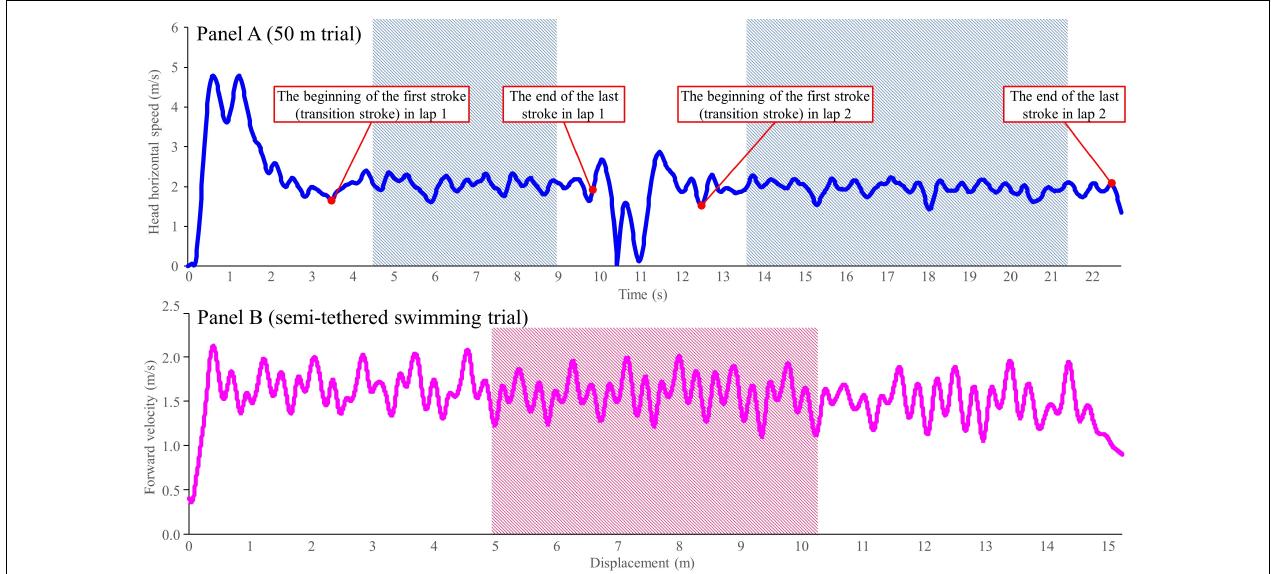
FIGURE 1 | Examples of collected data from the 50 m front crawl (panel A ) and semi-tethered swimming (panel B ) trials. The shaded area shows the range of data used for the analysis.